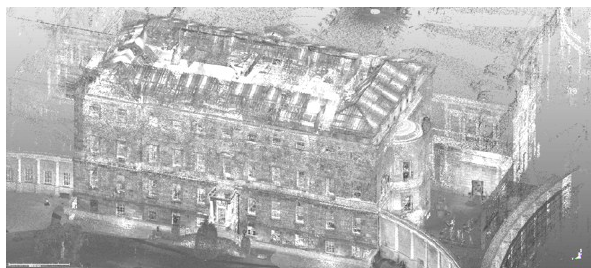
Figure 5: Point Cloud from Time of Flight Scanner